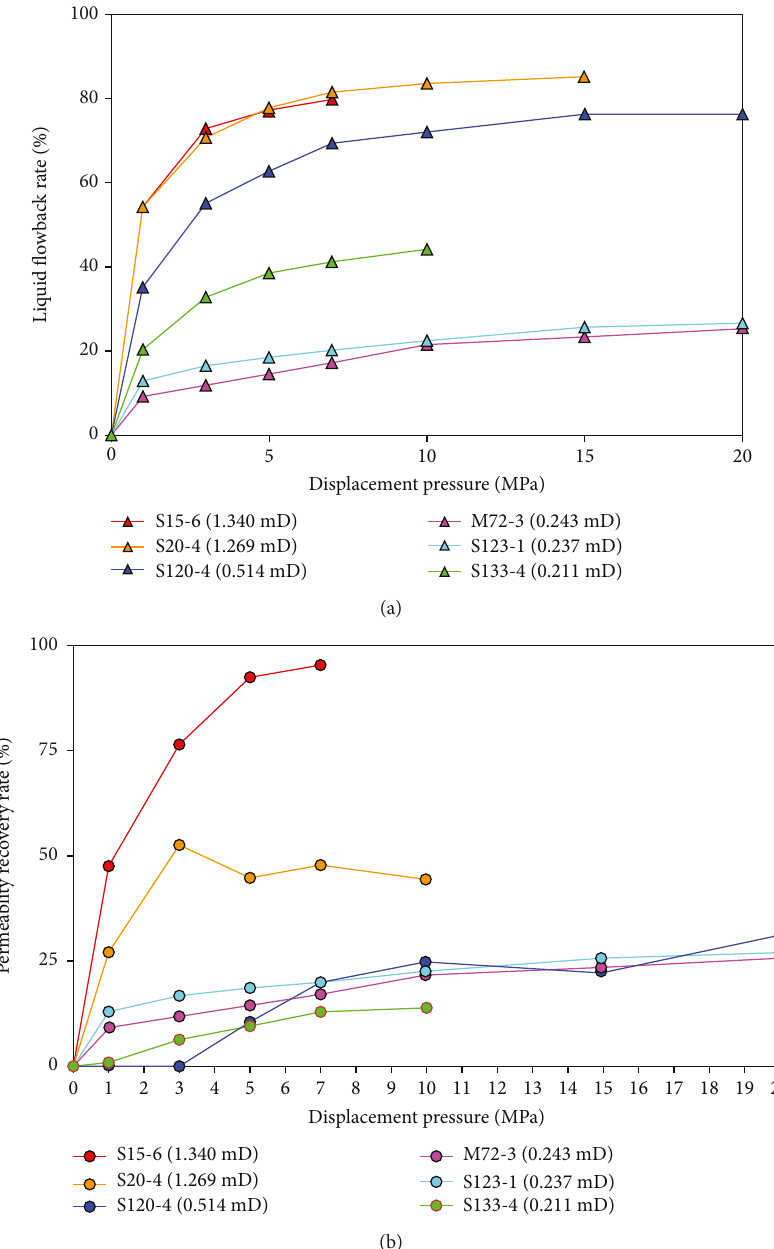
Figure 16: The variation of liquid fl owback rate and permeability recovery rate with di ff erent displacement pressure. Con fi ning pressure is